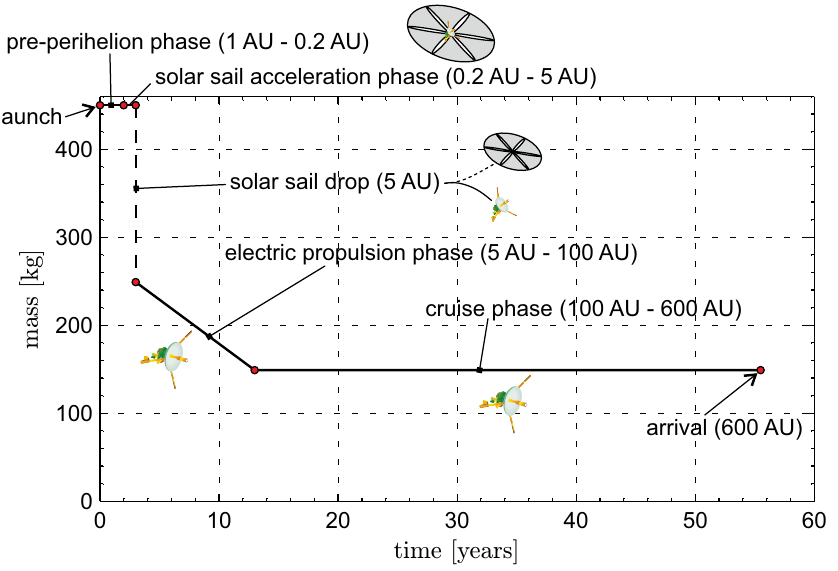
Figure 4. Graphical sketch and spacecraft mass variation of Hesperides baseline mission